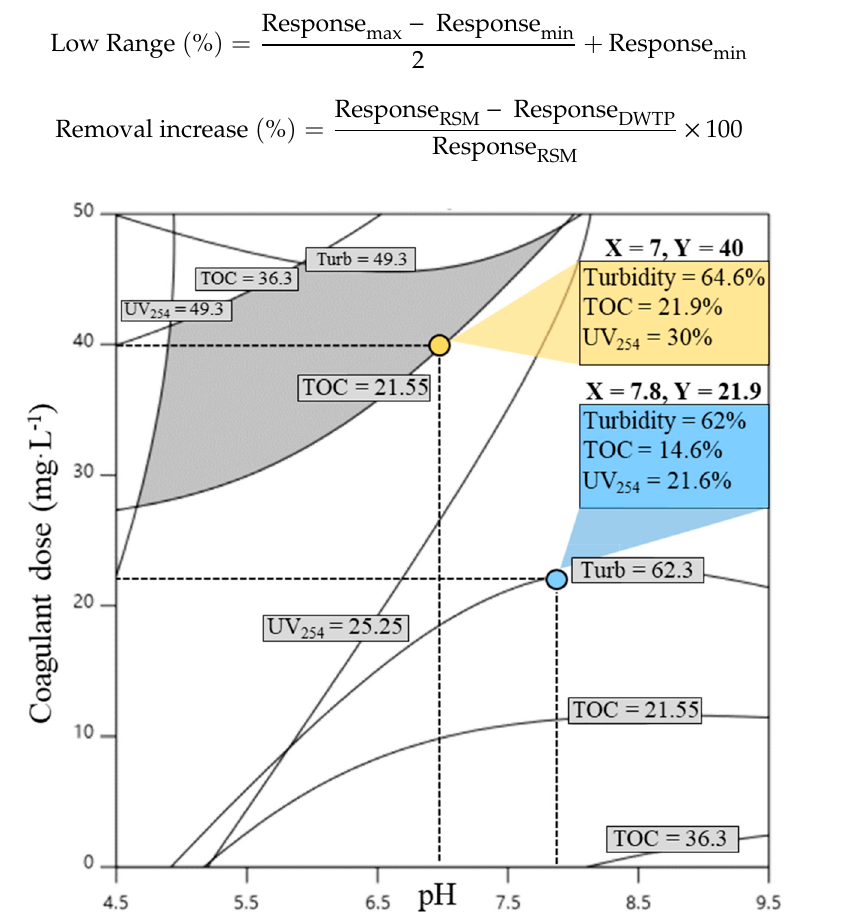
Figure 6. Responses overlay plots for turbidity, TOC, and UV 254 % of removal at the Montfullà DWTP. Regions that fit with fixed optimization criteria appear shaded in grey. The yellow circle represents optimum feasible conditions to achieve NOM enhanced coagulation and the blue circle shows real DWTP operation removals.